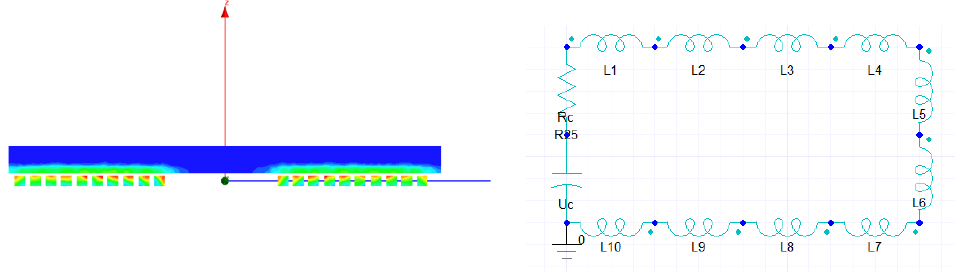
Figure 14. Drive model with solid coil and its external power supply circuit.